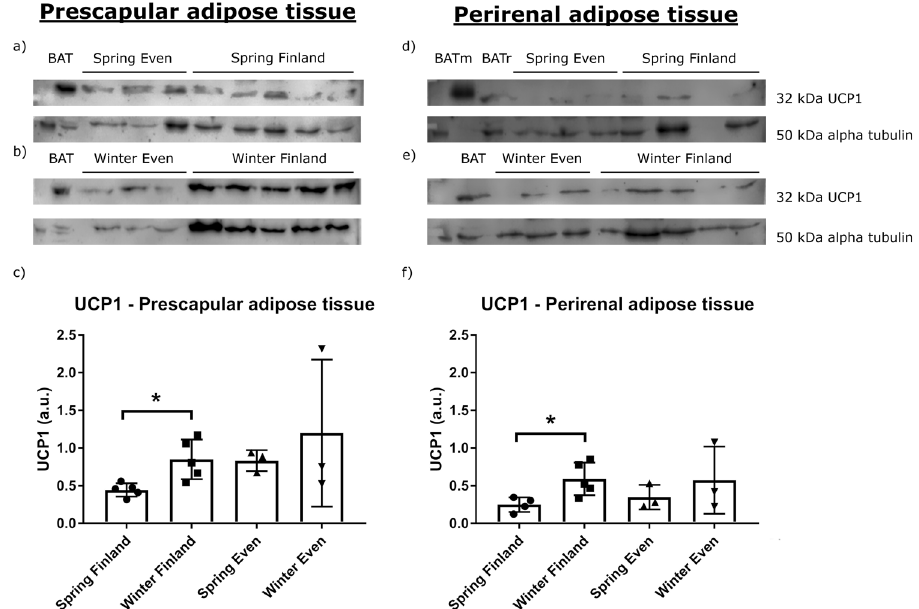
Fig. 4 UCP1 expression in each seasons and regions. The western blots and relative expression of UCP1 from a – c reindeer prescapular and d – f perirenal adipose tissue total proteins. The upper blots on the left side show UCP1 content in prescapular adipose tissue a in spring in Even reindeer ( n = 3) and Finnish reindeer ( n = 5), b in winter in Even reindeer ( n = 3) and Finnish reindeer ( n = 5), and the lower graph shows c their relative expression levels. The upper blots on the right side show UCP1 content in perirenal adipose tissue d in spring in Even reindeer ( n = 3) and Finnish reindeer ( n = 4), e in winter in Even reindeer ( n = 3) and Finnish reindeer ( n = 5), and the lower graph shows f their relative expression levels. Samples contained 50 µ g of total protein per lane, except the reindeer BAT (brown adipose tissue; BAT and BATr) samples with 5 µ g and mouse BAT (BATm) with 1 µ g of protein. Alpha tubulin was used as a loading control. The relative expression of UCP1 was normalized to alpha tubulin and presented as mean arbitrary units (a.u.) ± SD ( c , f ). Signi fi cant differences between seasons are indicated with a bar and an asterisk (* p <